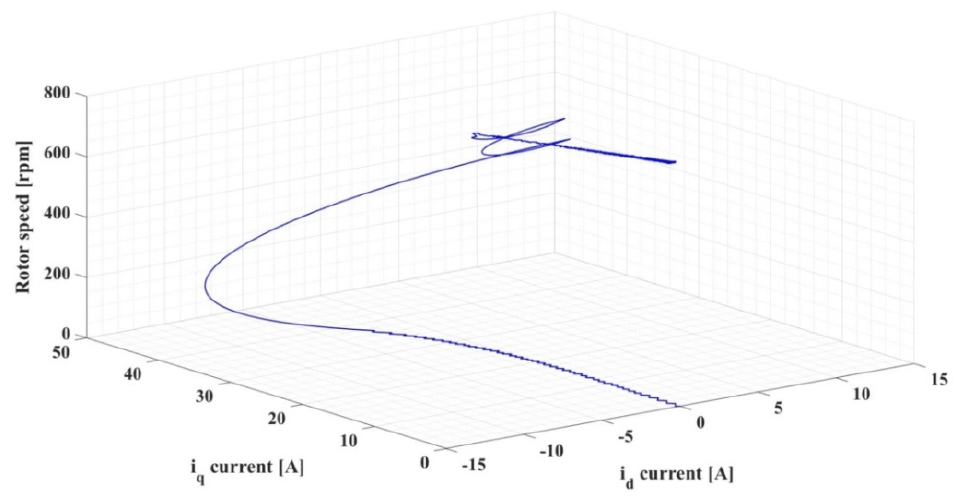
Figure 7. Image of the state space: rotor speed versus i q current versus i d current ( ω ref = 800 rpm).